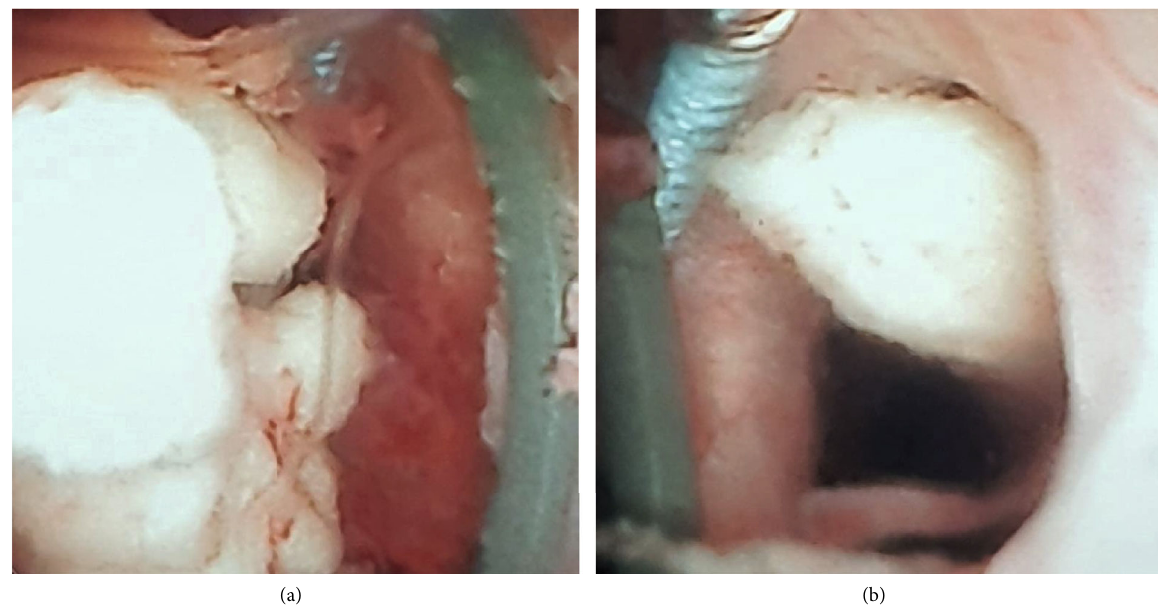
Figure 2: (a) Whitish, fl u ff y substance representing necrotic, sloughed papilla in in fl ammatory and hemorrhagic mucosal environment. (b) Sloughing necrotic papilla in the left-mid caliceal system.